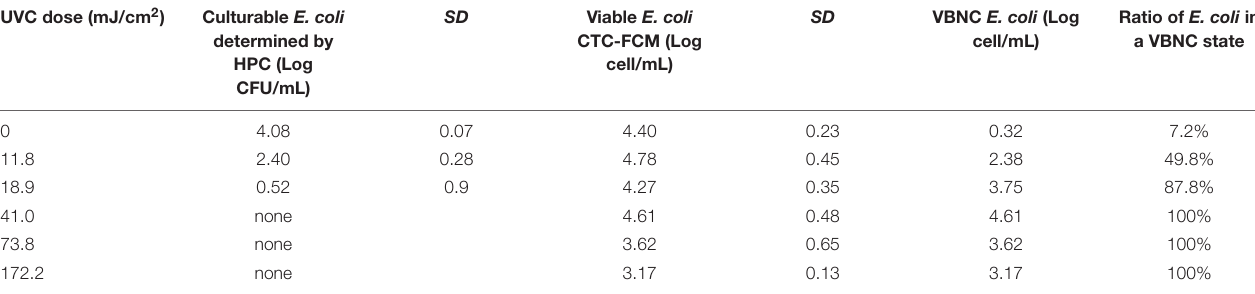
SD is the standard deviation of results from three independent experiments. ‘None’ indicates there is no culturable cells. TABLE 2 | Culturability, viability, and VBNC state of E. coli after continue-flow UVC treatment in simulated reclaimed water (SRW). UVC dose (mJ/cm 2 ) Culturable E. coli determined by